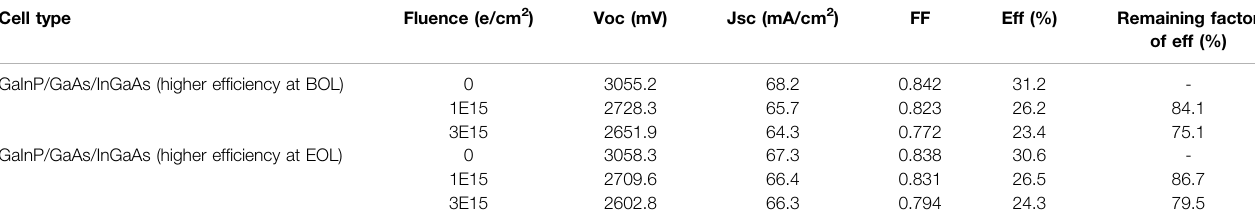
TABLE 3 | Changes of electrical parameters of IMM GaInP/GaAs/InGaAs triple-junction solar cell under 1 MeV electron irradiation [92]. Cell type